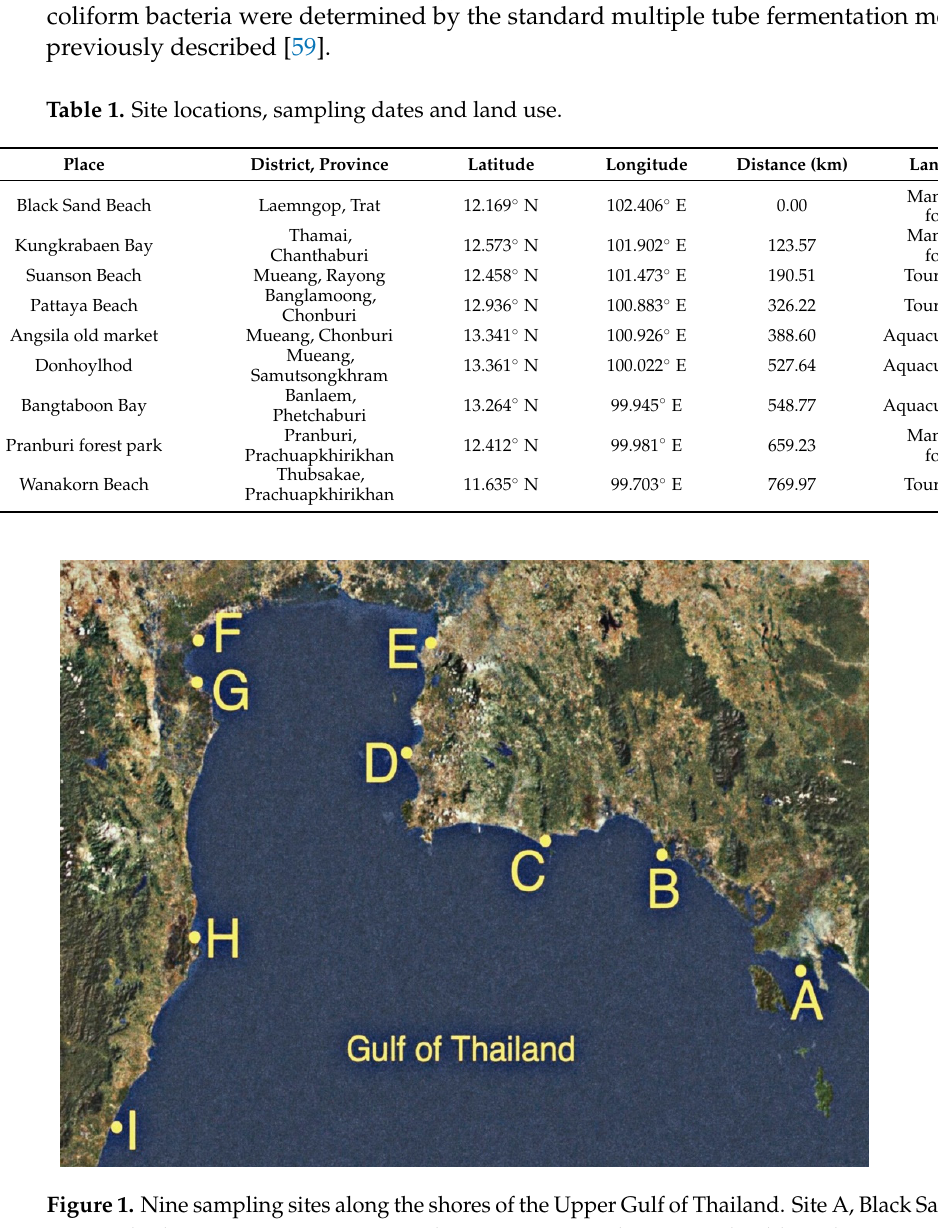
ERIC - PCR was performed to assess genotypic diversity and to reveal clusters among isolates as well as to differentiate individual strains . ERIC - PCR employed genomic DNA extracted from cell pellets of each isolate as a DNA template, a pair of primers ERIC2 ( 5 ′ AAG TAA GTG ACT GGG GTG AGC G 3 ′ ) and ERIC1R ( 5 ′ ATG TAA GCT CCT GGG GAT TAC C 3 ′ ) , and a thermal cycling condition consisting of a first denaturation step at 95 °C for 7 min, 30 cycles of denaturation at 95 °C for 1 min, annealing at 52 °C for 1 min, and extension at 65 °C for 8 min, and a final extension step at 65 °C for 16 min [60] . Nega- tive controls ( no DNA template ) were included in PCR reactions . The amplified fragments were separated by electrophoresis on 1%% agarose gels containing SafeView FireRed gel casting dye ( Applied Biological Materials Inc . , Richmond, BC, Canada ) and visualized with a Molecular Imager ® Gel DocTM XR + system ( Bio - Rad Laboratories, Hercules, CA, USA ). ERIC - PCR fingerprints and clusters were presented in the unweighted pair groups using mathematical averages ( UPGMA ) dendrogram created with the Phoretix ID Pro . software ( TotalLab Ltd . , Newcastle upon Tyne, UK ). The isolates generating distinct ERIC - PCR fin- gerprints were characterized as individual strains and then were subjected to further steps of the study . 2 . 3 . TP - RAPD Fingerprinting of Presumptive Enterobacterial Strains and Species Identification by Using the Vitek ® MS System TP - RAPD was performed to distinguish species among presumptive enterobacterial strains . Genomic DNA of each strain was used as a DNA template in PCR reactions using a pair of primers, 8F ( 5 ′ AGA GTT TGA TCC TGG CTC AG 3 ′ ) and 1522R ( 5 ′ AAG GAG GTG ATC CAN CCR CA 3 ′ ) ( R = C / T; N = A / G / C / T ). PCR cycles consisted of a first denatur- ation step at 95 °C for 9 min, and then 35 cycles of denaturation at 95 °C for 1 min, anneal- ing at 45 °C for 1 min, and extension at 72 °C for 2 min, followed by a final extension step at 72 °C for 7 min [61] . Negative controls ( no DNA template ) were included in PCR reac-